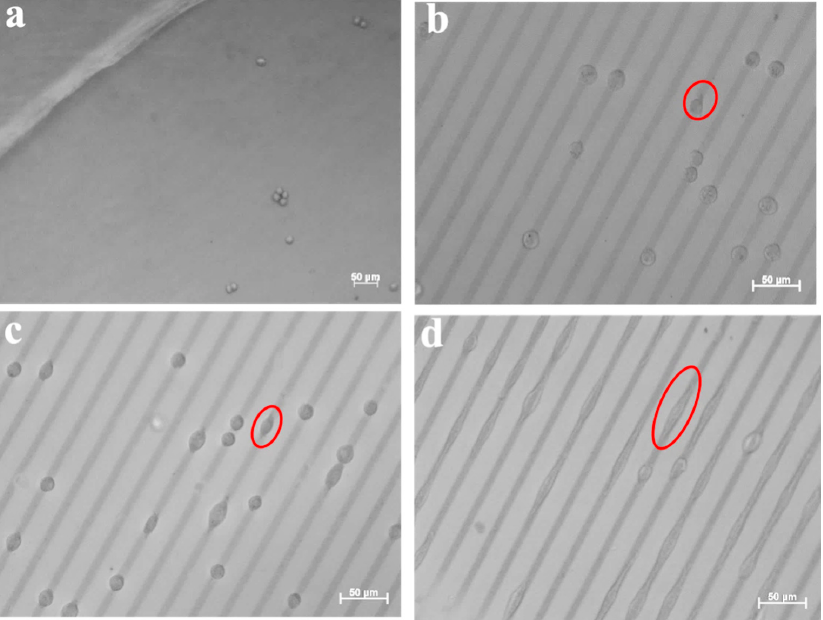
Figure 9. Optical images of L-929 cells after incubation with patterned Au NPs (d = 20 nm) on the surface of hydrogels (20 μ m inter-stripe distances) at different incubation times: ( a ) pure PEG gel (8PEG-VS-SH); ( b ) 3 h; ( c ) 24 h and ( d ) 48 h, respectively. Red ellipses refer to L-929 cell growing on the patterned Au NPs stripes.